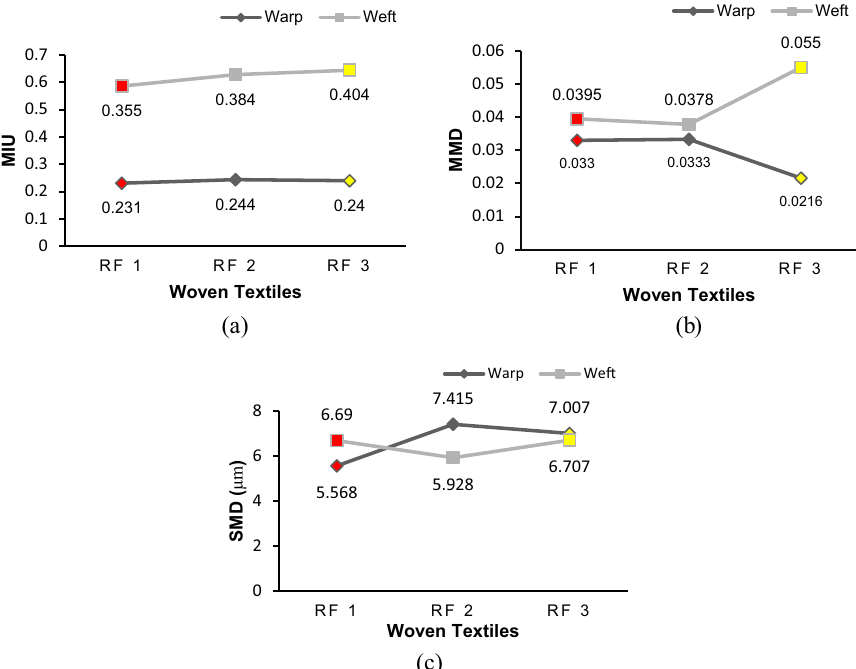
Fig. 11 a Coefficient of friction (MIU), b fabric mean deviation (MMD) and c fabric roughness (SMD—µm). RF Reflective